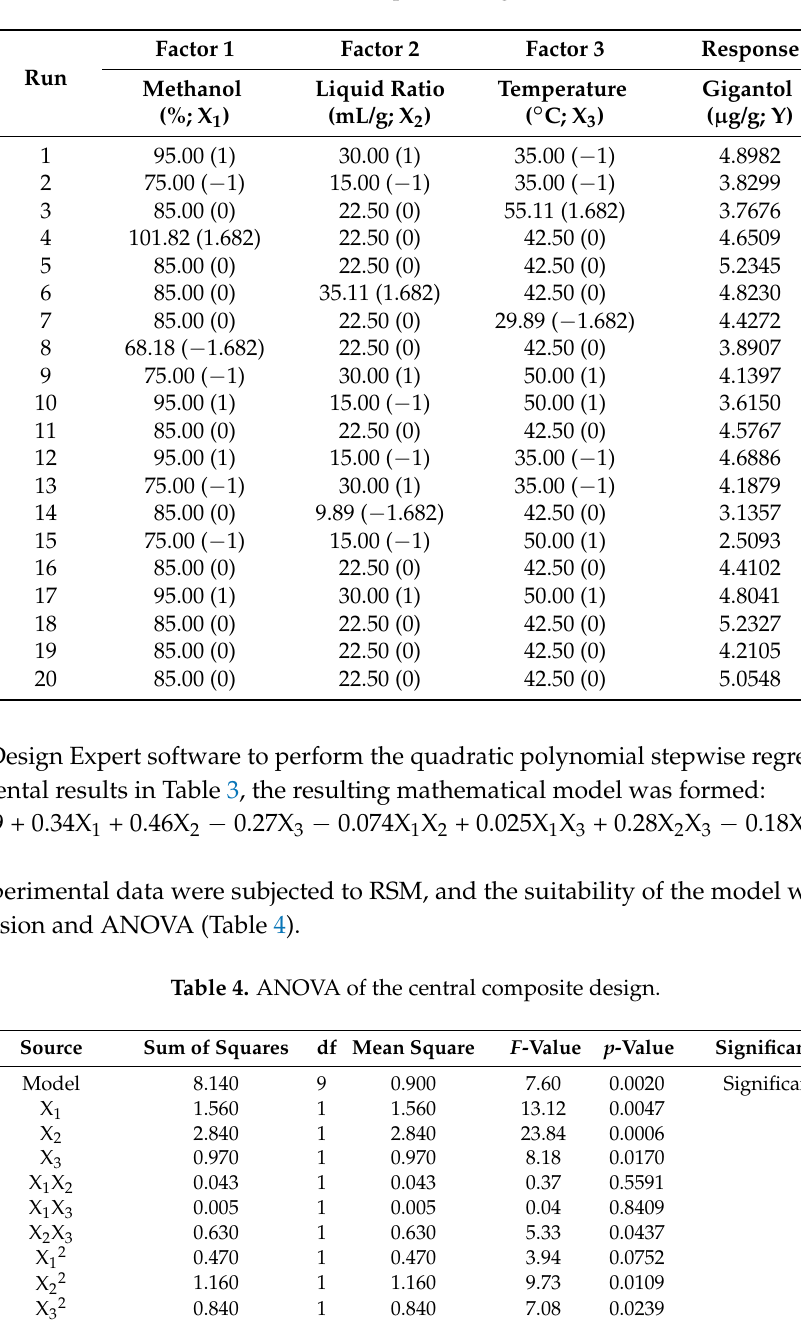
Table 3. Central composite design and results.